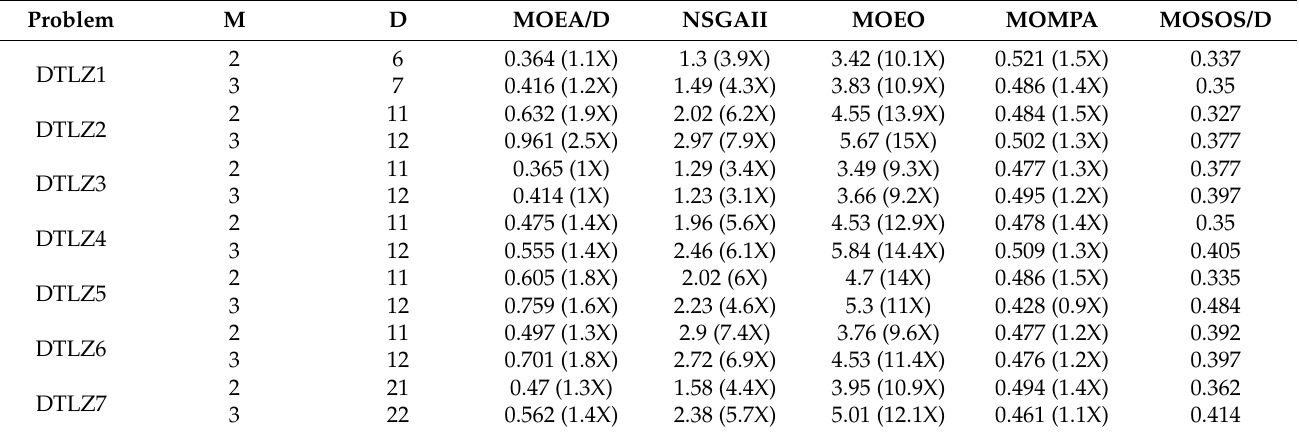
Table 6. The RT (average CPU time/ computational complexity) metric